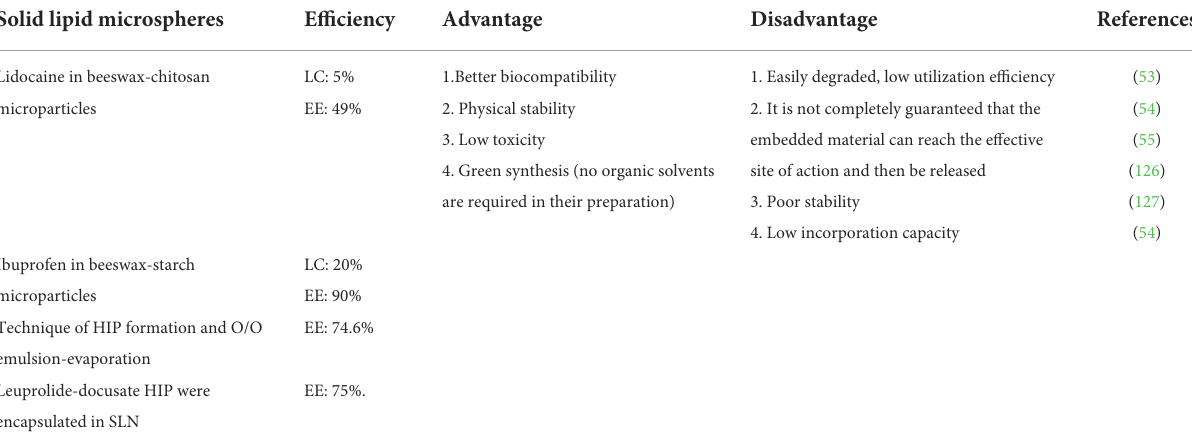
TABLE 2 Application and characterization of solid lipid nanoparticles. Solid lipid